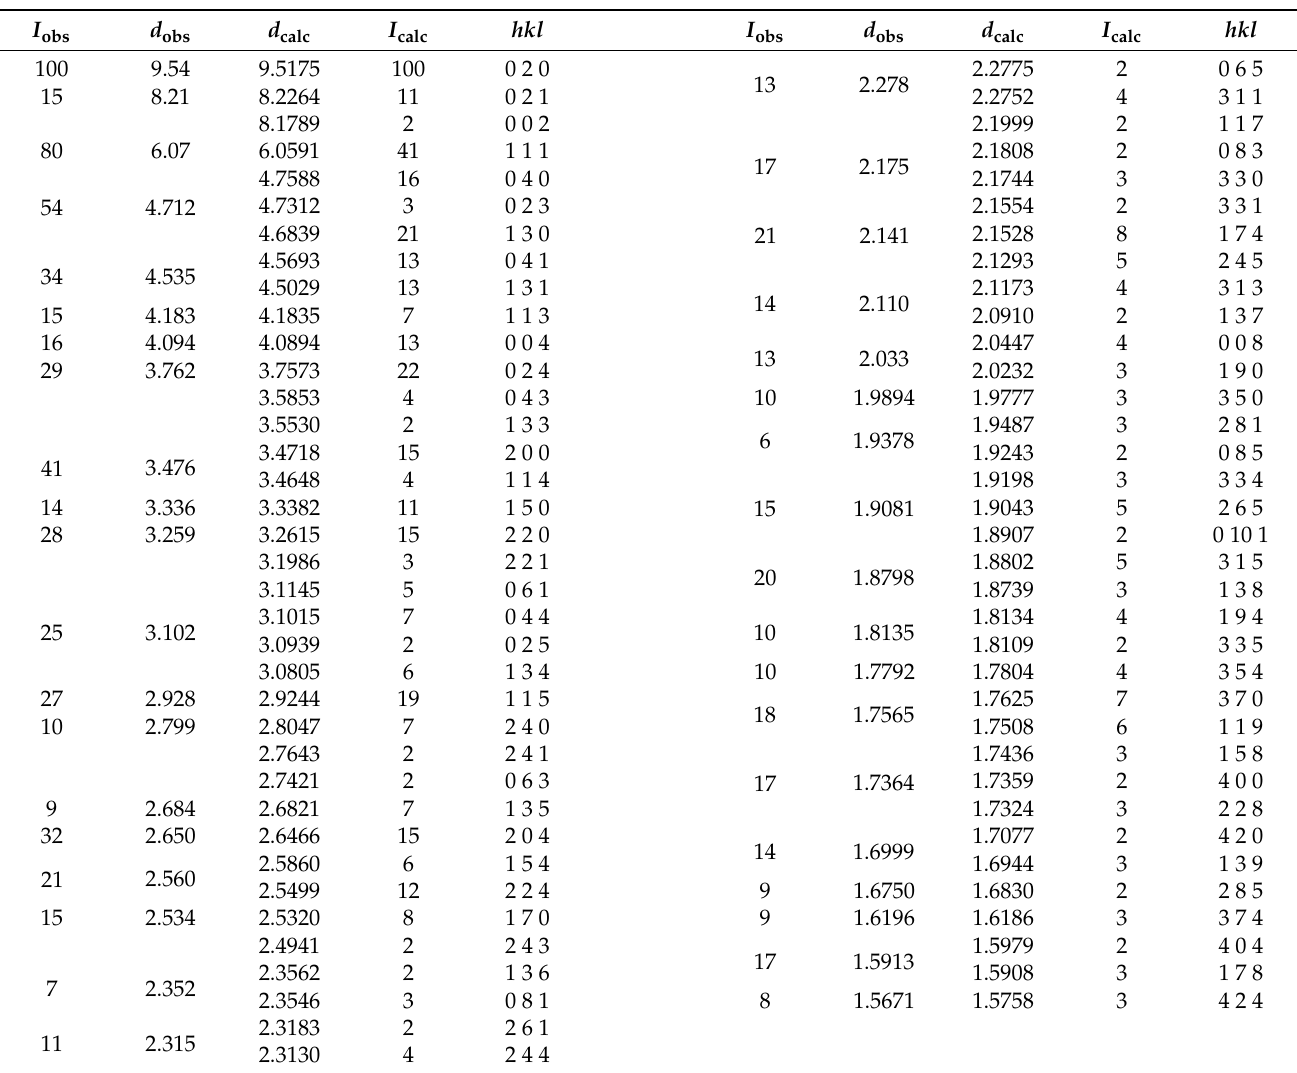
Table 2. Powder X-ray data ( d in Å) for chenowethite. Only calculated lines with I ≥ 1.5 are